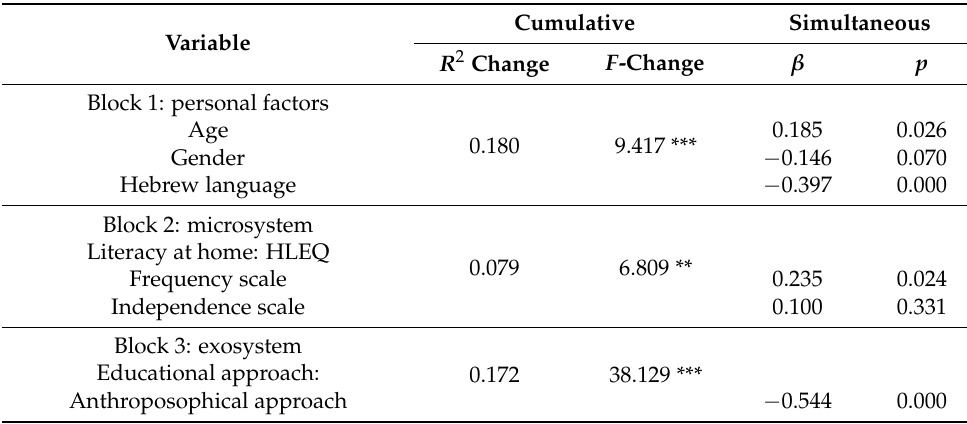
Table 5. Regression analysis for GIFT total score with associated factors. Cumulative Variable